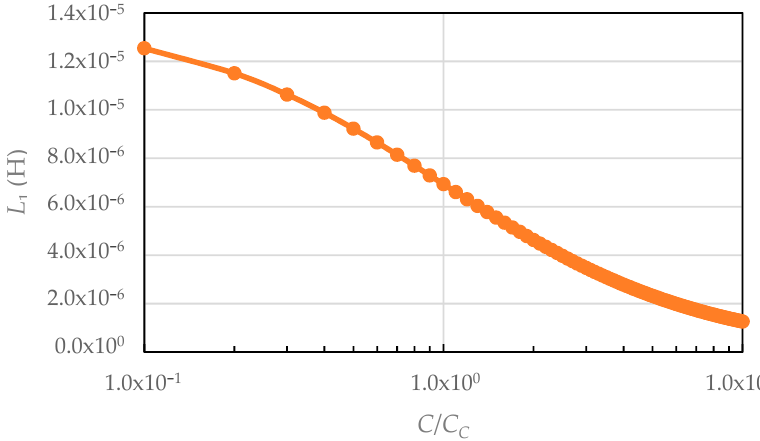
Figure 13. Inductor value L 1 for various ratios of primary capacitance to coupling capacitance.